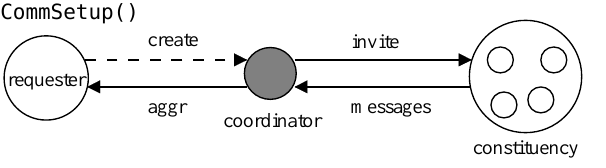
Figure 2. Multi-Origin Communication Setup